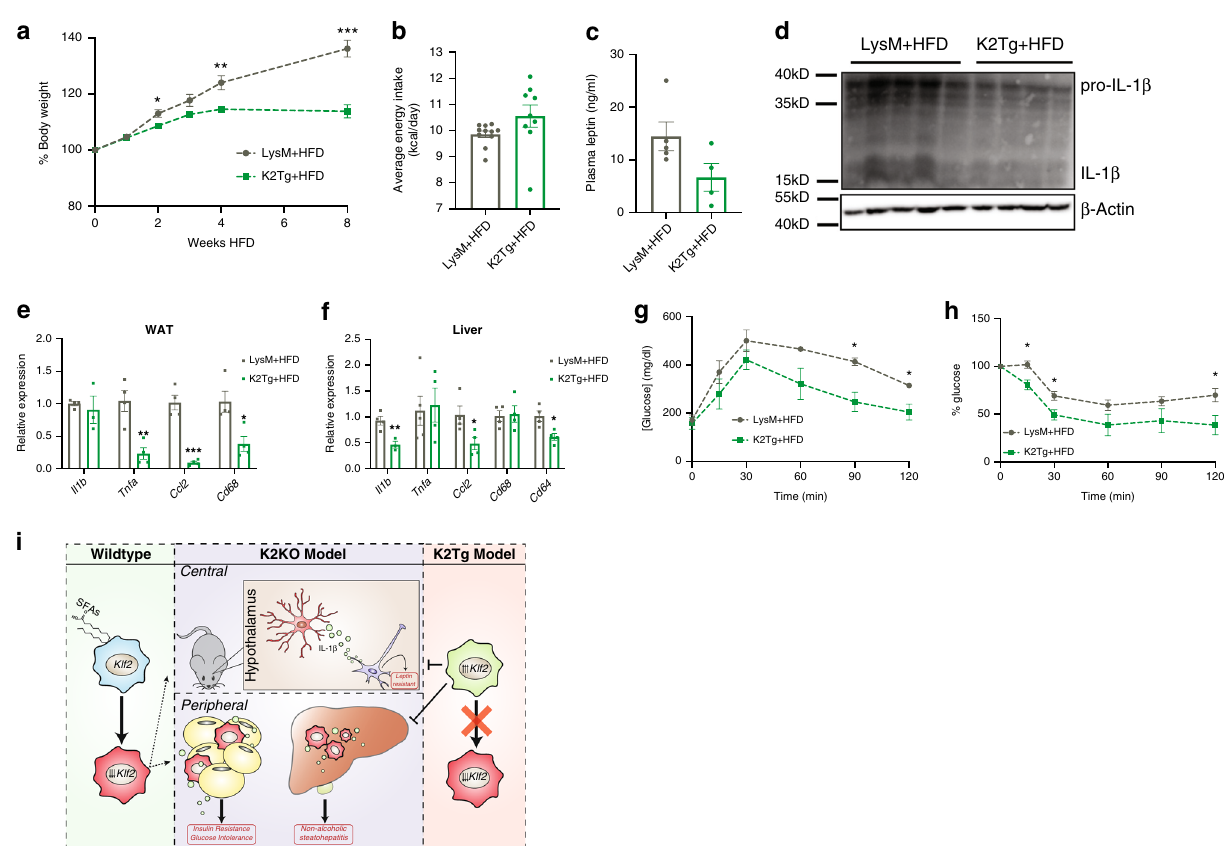
Fig. 6 Overexpression of myeloid KLF2 protects against metabolic disease. a Myeloid KLF2 overexpressing mice (K2Tg) are protected against HFD- induced weight gain, n = 15, p = 0.0253 (2 weeks), 0.00238 (4 weeks), 0.005 (8 weeks). b K2Tg mice consume similar amounts of food daily compared to LysM mice across a HFD regimen, LysM n = 11, K2Tg n = 9. c K2Tg have diminished plasma leptin levels after HFD, LysM n = 5, K2Tg n = 4. d Western blot on hypothalamic lysates from HFD-fed mice demonstrate decreased interleukin-1 beta (IL-1 β ) production in K2Tg mice, LysM n = 5, K2Tg n = 4. e K2Tg have decreased in fl ammatory gene expression in WAT after HFD, n = 4, p values: Tnfa = 0.0046 , Ccl2 = 0.00019, Cd64 = 0.0168. f K2Tg have decreased in fl ammatory gene expression in liver after HFD, n = 4, p values: Il1b = 0.0099, Ccl2 = 0.0394, Cd64 = 0.0155. g IPGTT and h IPITT demonstrating improved glucose handling by K2Tg after HFD, LysM n = 4, K2Tg n = 5. i Working model describing how myeloid KLF2 expression affects metabolic disease centrally and peripherally. * p < 0.05, ** p < 0.01, *** p < 0.001 by unpaired two-tailed Student ’ s t -test. Error bars represent SEM. All mice on were fed HFD for 1 month unless otherwise indicated. n represents biologically independent mice throughout entire fi gure. Source data are provided as a Source Data fi